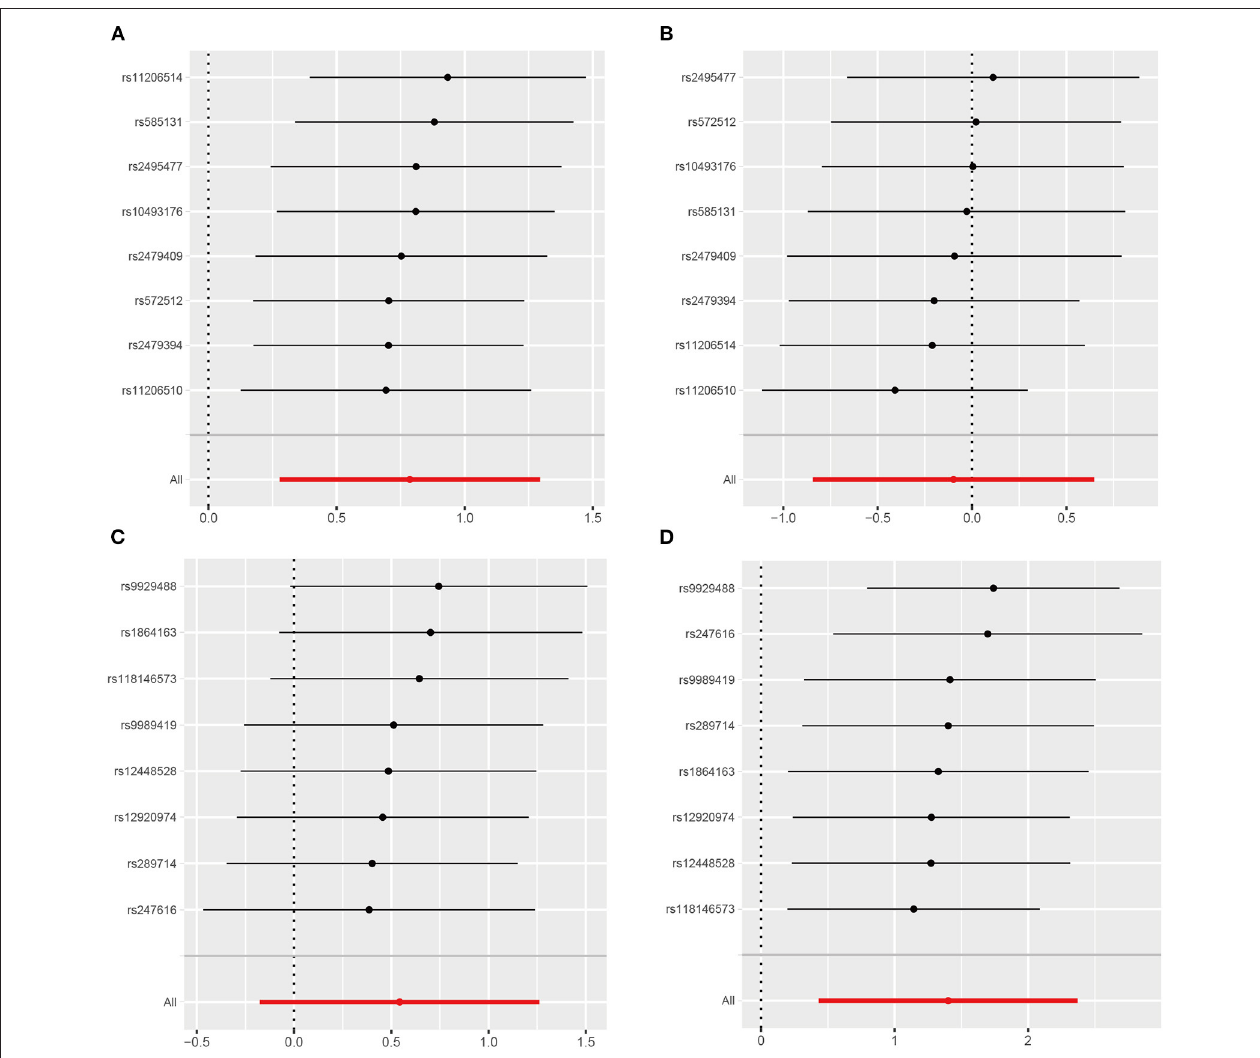
FIGURE 4 | Leave-one-out analysis of genetically proxied PCSK9 and CETP inhibition on RCC risk in men and women. (A) PCSK9 inhibitor and RCC risk in men; (B) PCSK9 inhibitor and RCC risk in women; (C) CETP inhibitor and RCC risk in men; (D) CETP inhibitor and RCC risk in women.